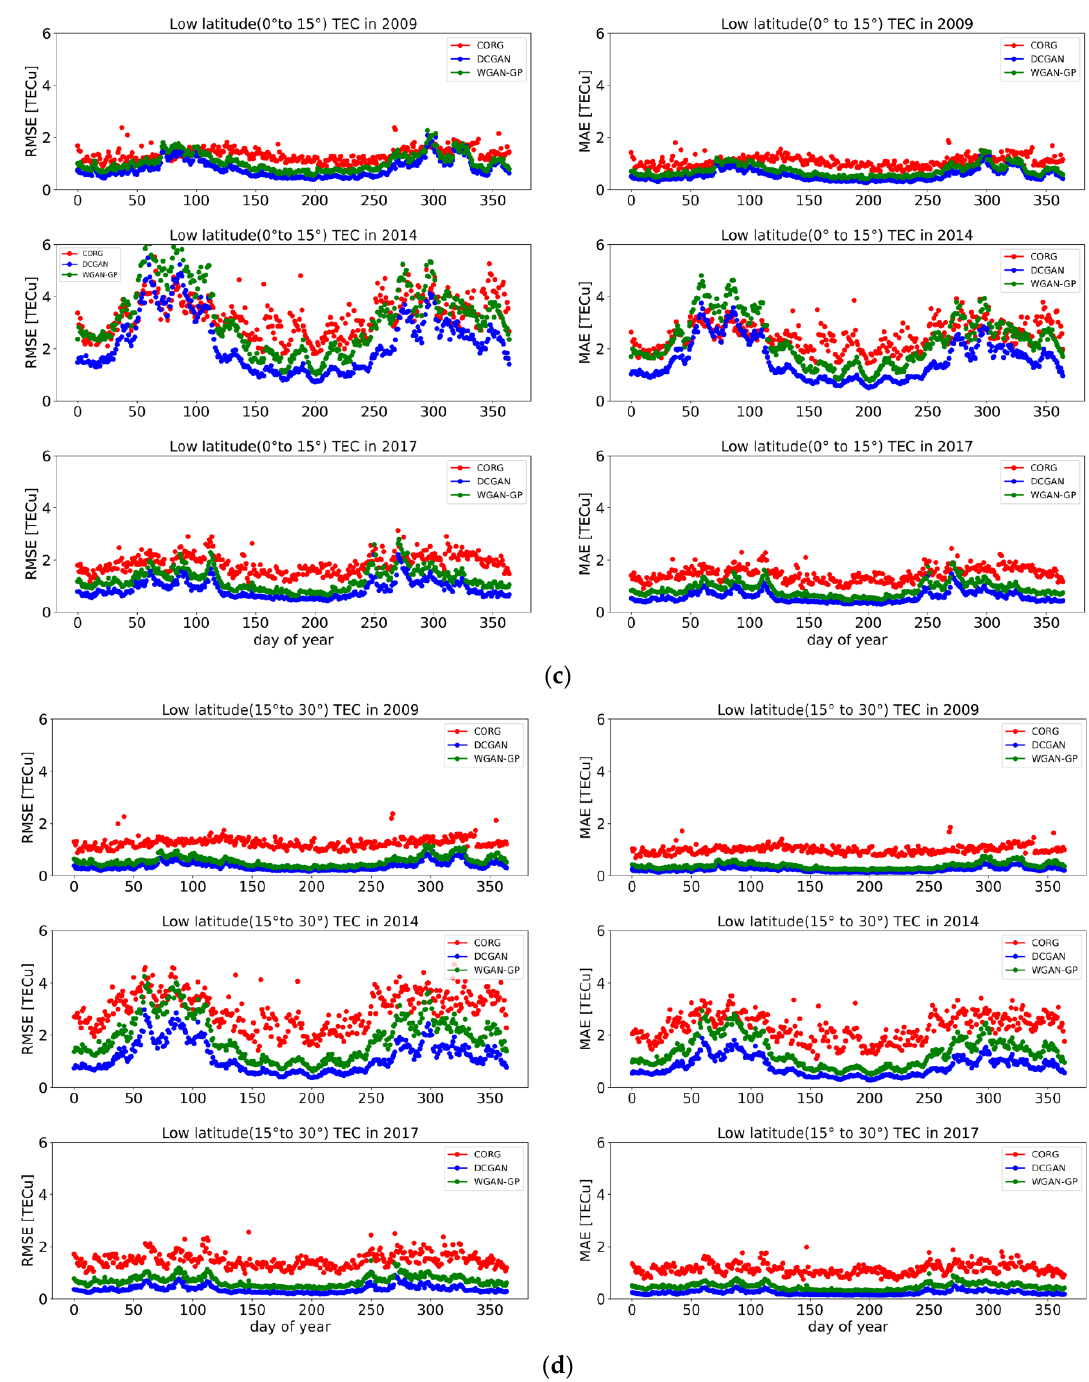
Figure 10. The daily RMSE and MAE in high latitude (87.5 ° S – 60 ° S, 60 ° N – 87.5 ° N), midlatitude (60 ° S – 30 ° S, 30 ° N – 60 ° N), and low latitude (30 ° S – 30 ° N) for CORG (red dots), DCGAN (blue dots), and WGAN-GP (green dots) in 2009, 2014, and 2017.